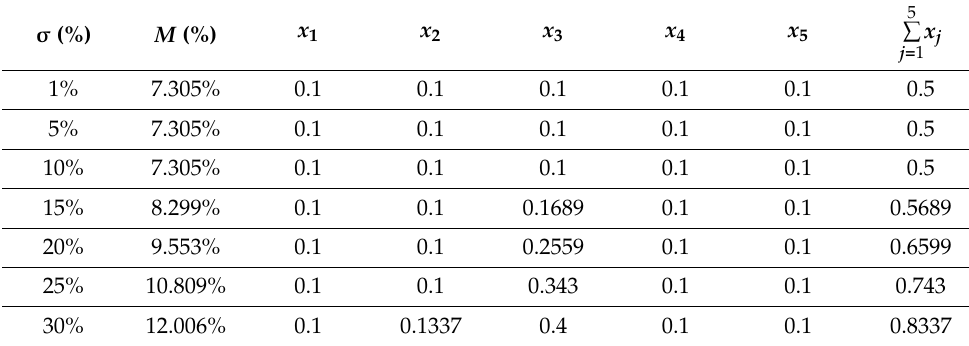
Table 3. The possibilistic efficient portfolios with b = 0.15, p 1 = 0.4, p 2 = 0.3, p 3 = 0.3.